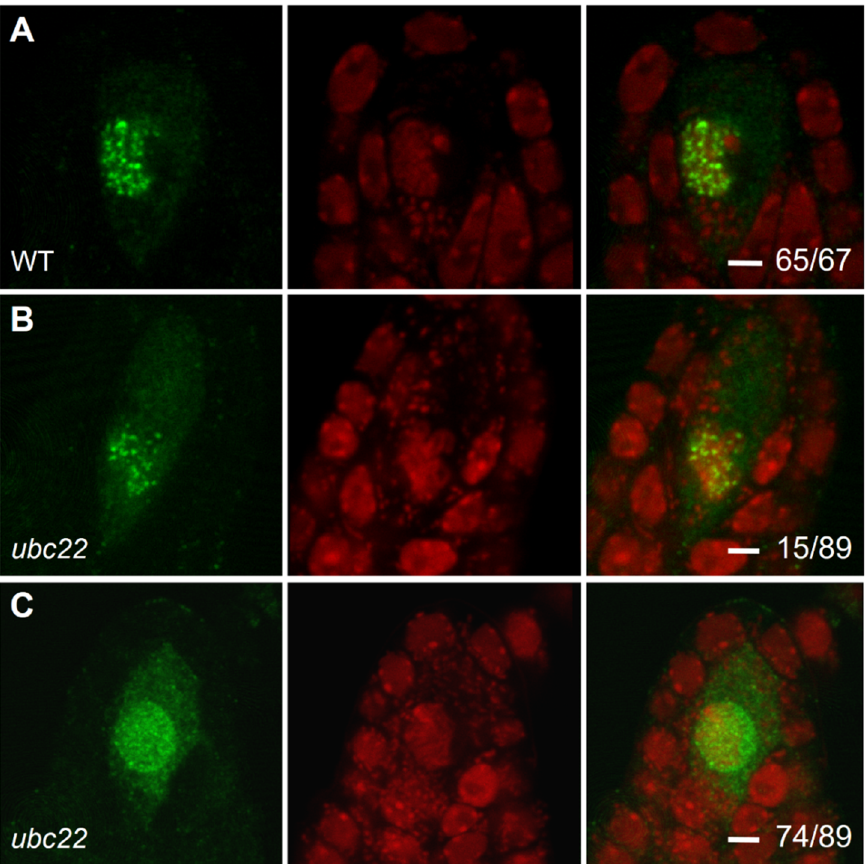
Figure 4. DMC1 immunolocalization in WT and ubc22 mutant ovules. WT and ubc22-1 mutant ovules were dissected, fixed and processed for immunostaining with an antibody against DMC1 (green color). They were also stained with propidium iodide (PI, red color). ( A ) In the WT ovules, DMC1 accumulates during prophase I in the MMC as foci along chromosome axes. ( B ) A small portion (about 17%) of the mutant ovules had a DMC expression pattern similar to the WT, although the foci were less intense. ( C ) In the majority of ubc22-1 ovules (83%), DMC1 signals were spread out loosely in the nucleus. In each row, the left image shows DMC1 staining, the center shows PI staining and the right shows the overlay of the two images. The numbers in the right images indicate the frequencies of the ovules with their expression pattern. Scale bars = 2 μ M.